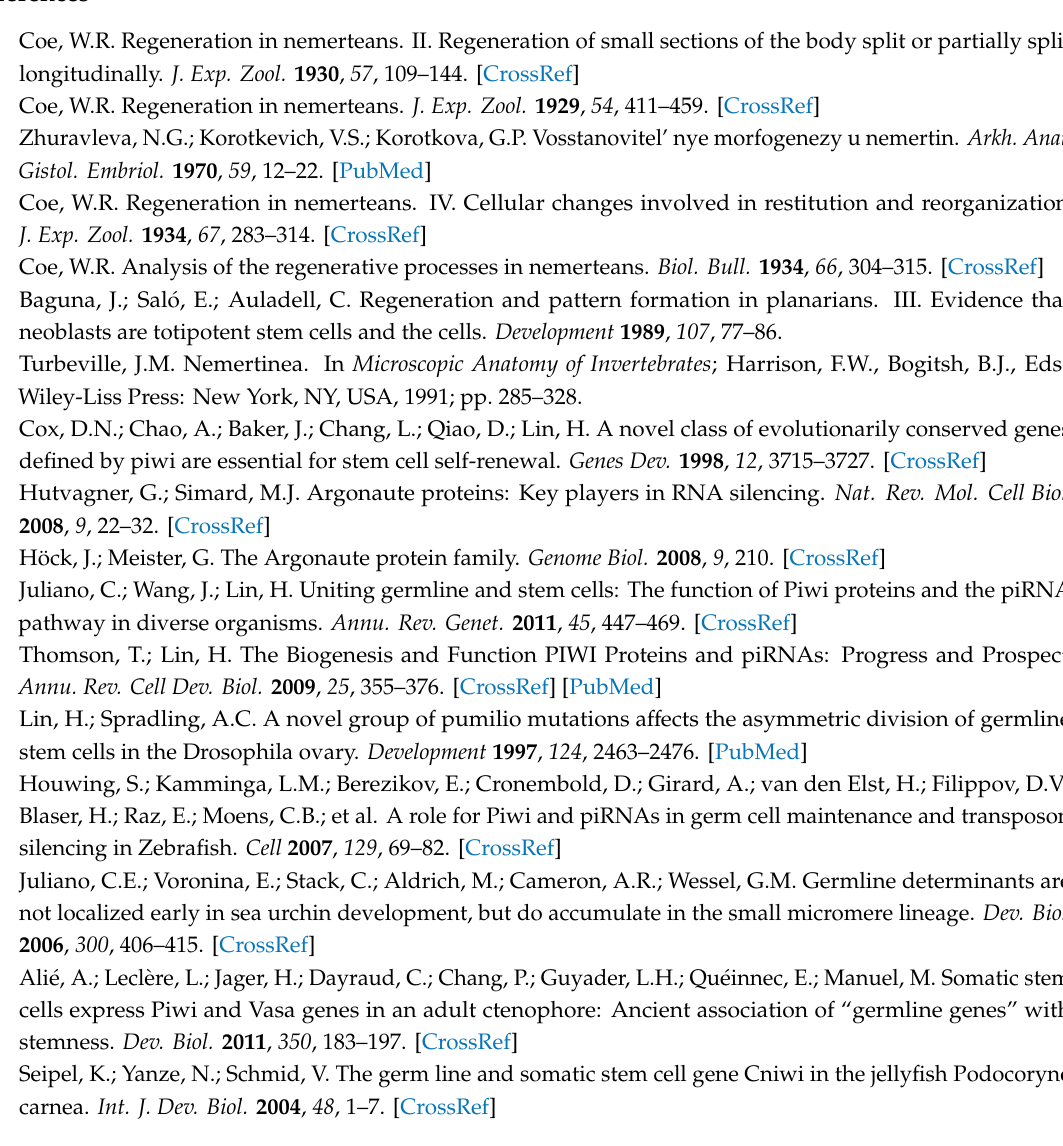
Table S1: Species and their GenBank accession numbers of Argonaute protein family used for phylogenetic analysis; Figure S1: Time course of the regeneration of Lineus sanguineus (ventral view); Figure S2: Domain structures of the inferred Argonaute proteins in Lineus sanguineus and Notospermus geniculatus ; Figure S3: A comparison of the deduced amino-acid sequences of the proliferating cell nuclear antigen (PCNA); Figure S4: Micrographs for sense-probe staining (control) of four genes in Lineus sanguineus ; Figure S5: Expression patterns of Ls-pcna , Ls-piwi1 , Ls-piwi2 , and Ls-piwi3 in the intestinal region of non-starved Lineus sanguineus